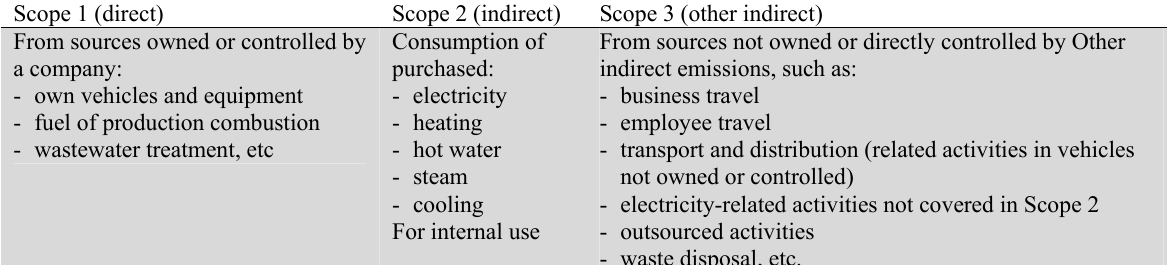
Three categories of